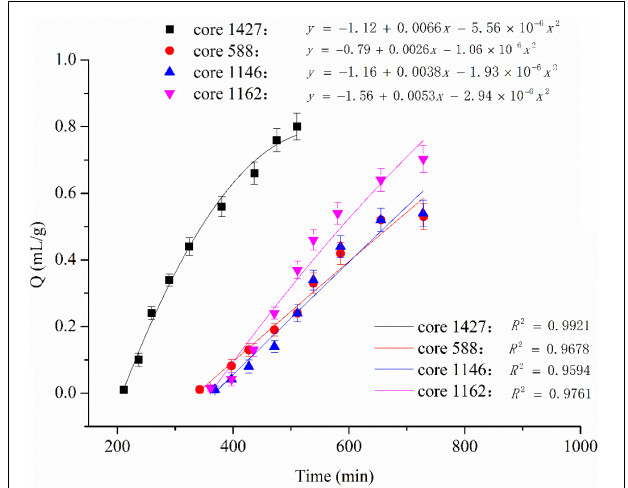
FIGURE 10 | The relationship curve of shale gas loss over time in the experiment.